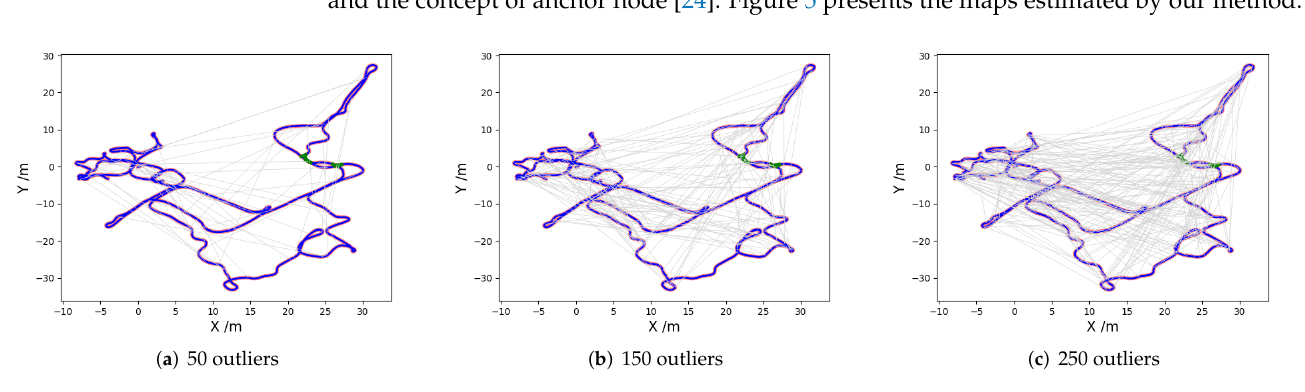
Figure 5. Estimated maps for CSAIL dataset. ( a – c ): Optimized graph after our method in the presence of 50, 150, and 250 outliers. Correctly accepted inlier constraints are green, disabled outliers in gray, final optimized map in blue.